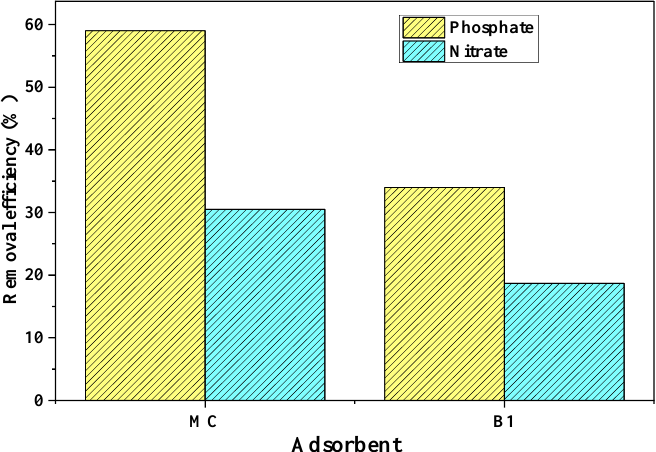
Figure 8. Competitive removal of Nitrate and Phosphate.